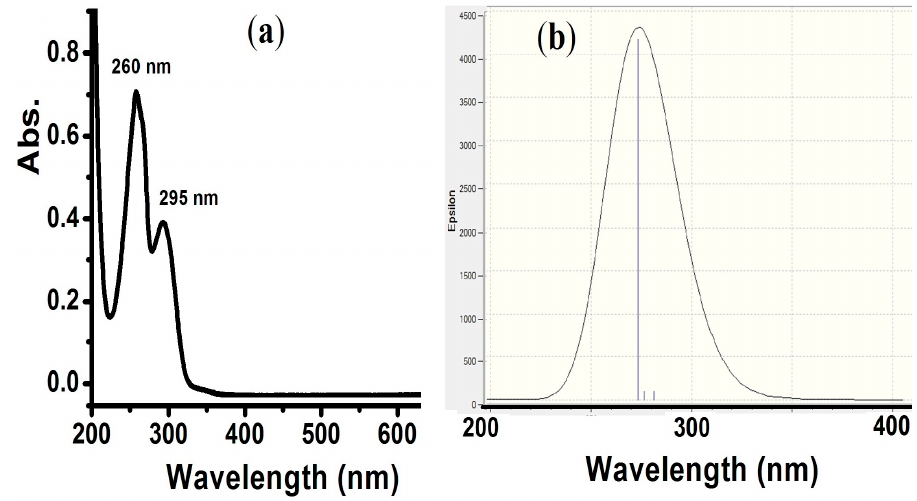
Figure 3 . ( a ) UV-Visible spectrum and ( b ) TD-SCF-DFT of the compound in MeOH at RT.